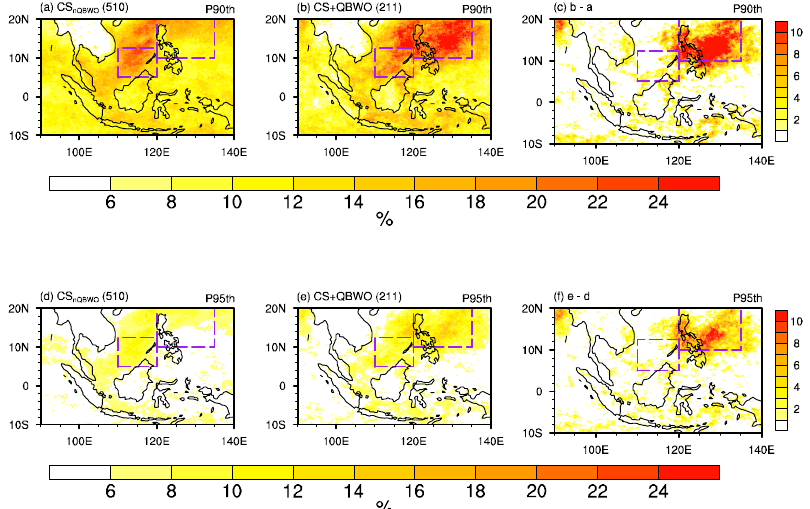
Figure 8. Probability (shade, SI = 2%) of extreme rainfall that exceeds the (upper panel) 90th threshold and (lower panel) 95th threshold during cold surge days ( a , d ) without and ( b , e ) with the QBWO, respectively. ( c ) and ( f ) are the differences in percent probability between the days when a cold surge and the QBWO co-exist and the days of a cold surge without the QBWO (shade, SI = 1%). Rectangles represent the regions over the EPH (10°–20°N, 120°–135°E) and NBO (5°–12.5°N, 110°–120°E), respectively.